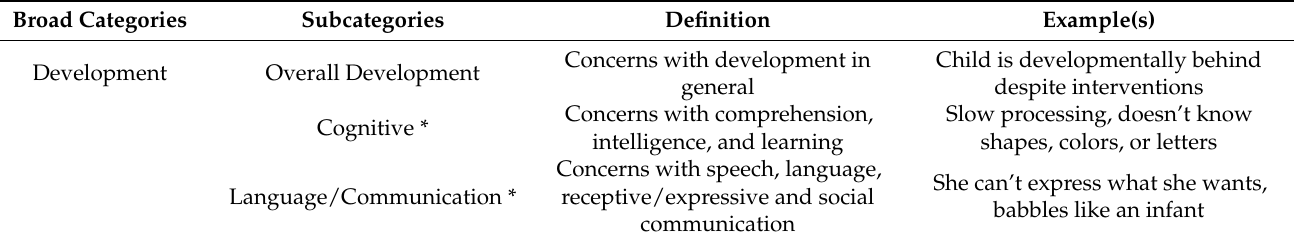
Table A1. Final Coding System Documenting 19 Unique